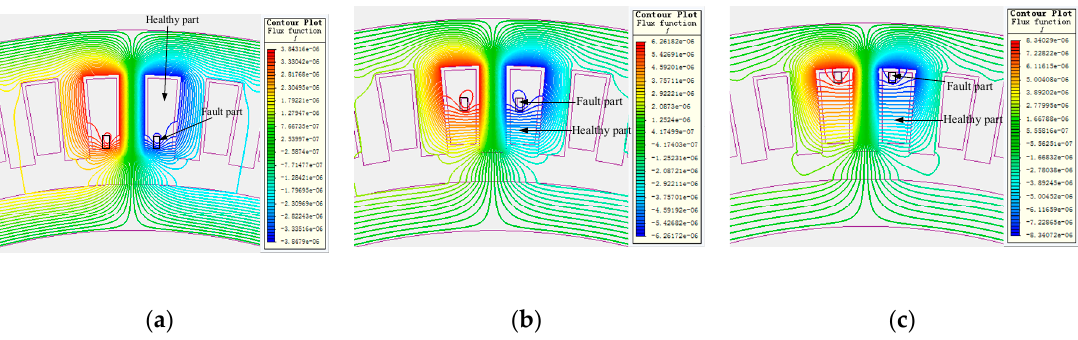
Figure 8. The flux density distributions when there are two turns shorted in layer 2: ( a ) no. 13, 14; ( b ) no. 18, 19; ( c ) no. 23, 24.